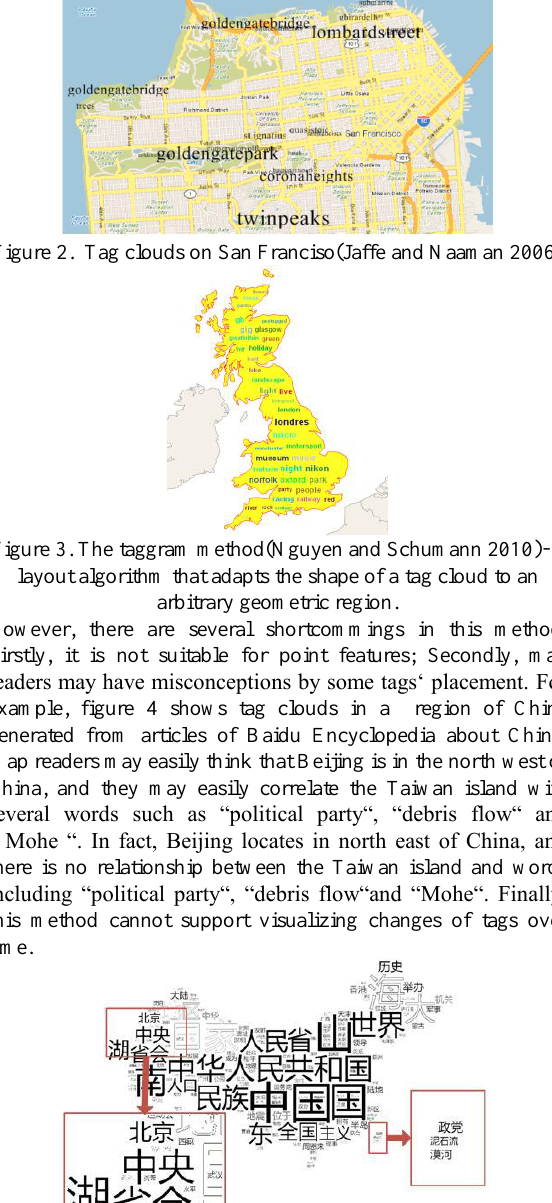
Figure 4. A tag clouds in a region of China generated from articles of Baidu Ency-clopedia about China